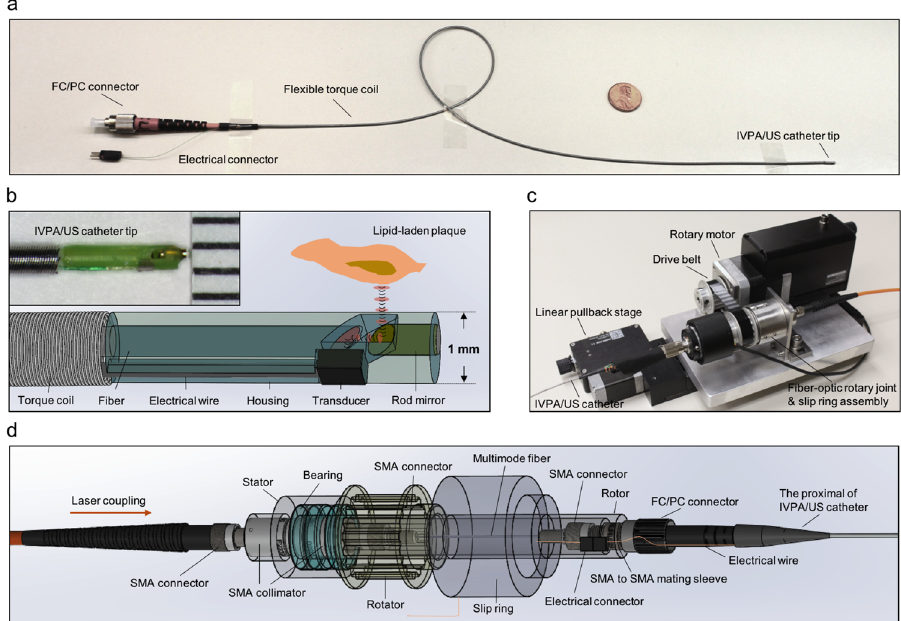
Figure 3. 1-mm high-sensitivity catheter and fiber-optic rotary joint assembly for high-speed IVPA-US imaging. ( a ) Gross picture of flexible IVPA-US catheter with a 1 cent coin. Proximal end of the catheter was assembled with a FC/PC connector. ( b ) Schematic of 1-mm collinear IVPA-US catheter design. The red ellipses and black curves highlight the collinear paths of optical pulses and acoustic waves, respectively. Inset shows the actual picture of assembled catheter tip. Ruler scale: 1 mm. ( c ) Picture of overall fiber-optics rotary joint assembly. ( d ) Schematic of fiber-optic rotary joint for high-pulse-energy high-repetition-rate laser